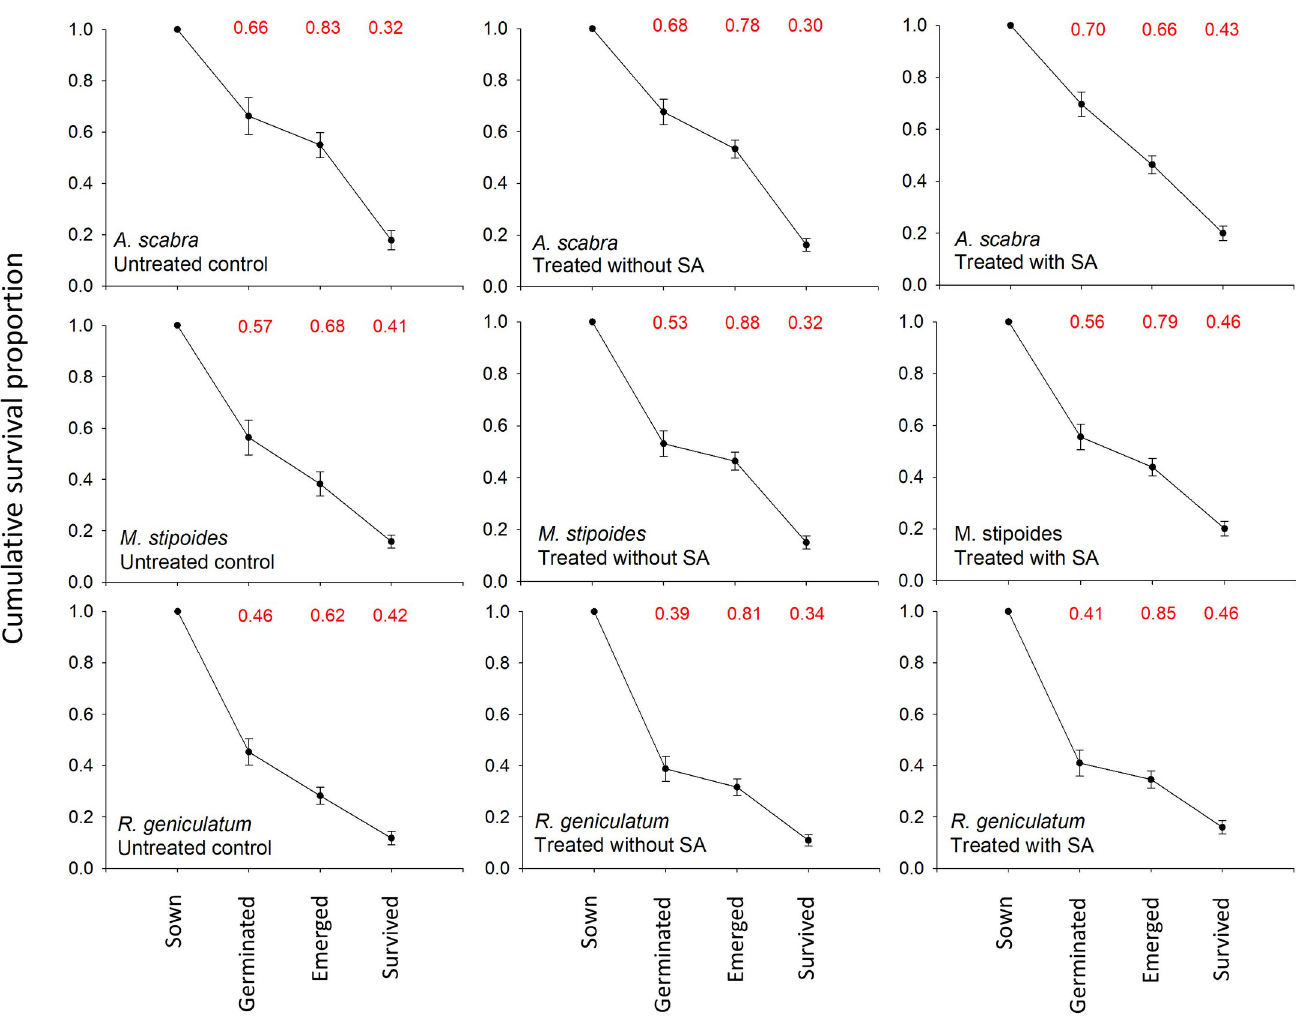
Fig 6. Cumulative survival proportion. Demographic process through various life stages for the three species tested without treatment, treated without SA (IN + EN) and treated with SA (IS + ES). On the top of each graph, in red, are reported the probability of transitioning between life stages. This demographic data are based on the “in line” experiment whereas seedlings were not removed after